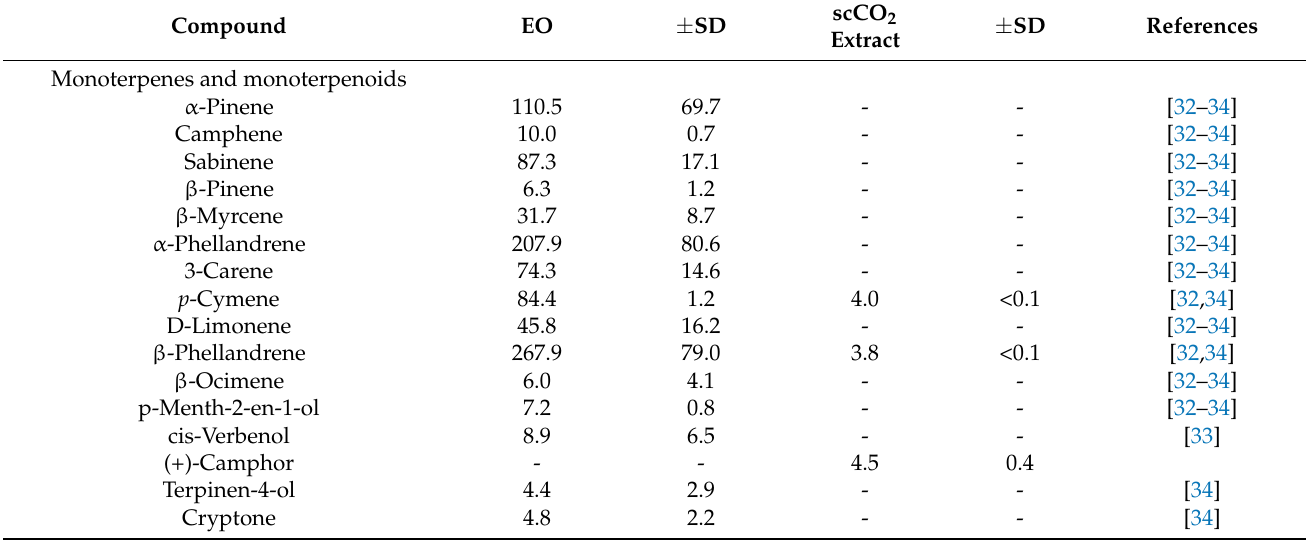
Table 3. Terpene and volatile content (mg/g) of air-dried Angelica root EO ( 1 ) and scCO 2 extract ( 4 ).